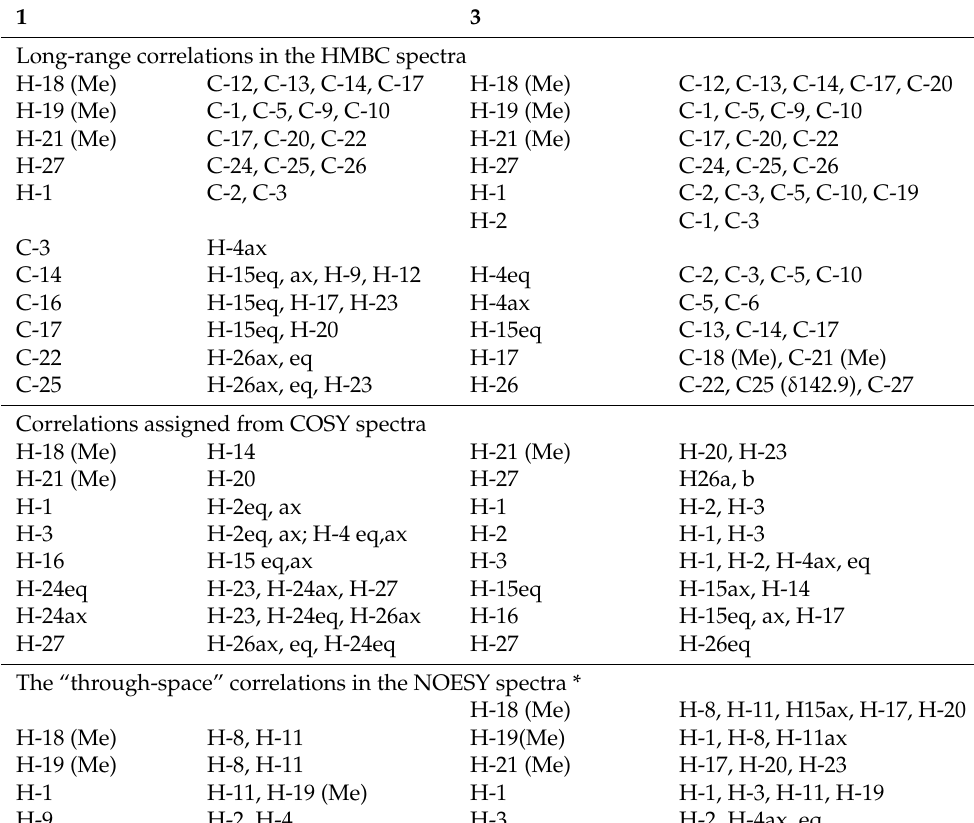
Table 2. Characteristic correlations in the 2D spectra of 1 and 3